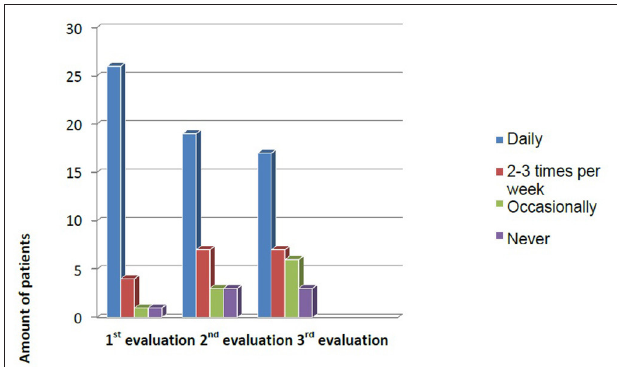
FIGURE 4 | Evolution of adherence to CG use during the first